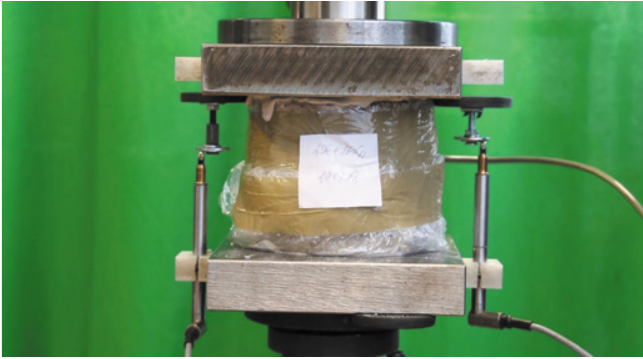
Figure 2. UCS testing of sample (2.5% CEM II/ B-T 42.5R + 20% Fly